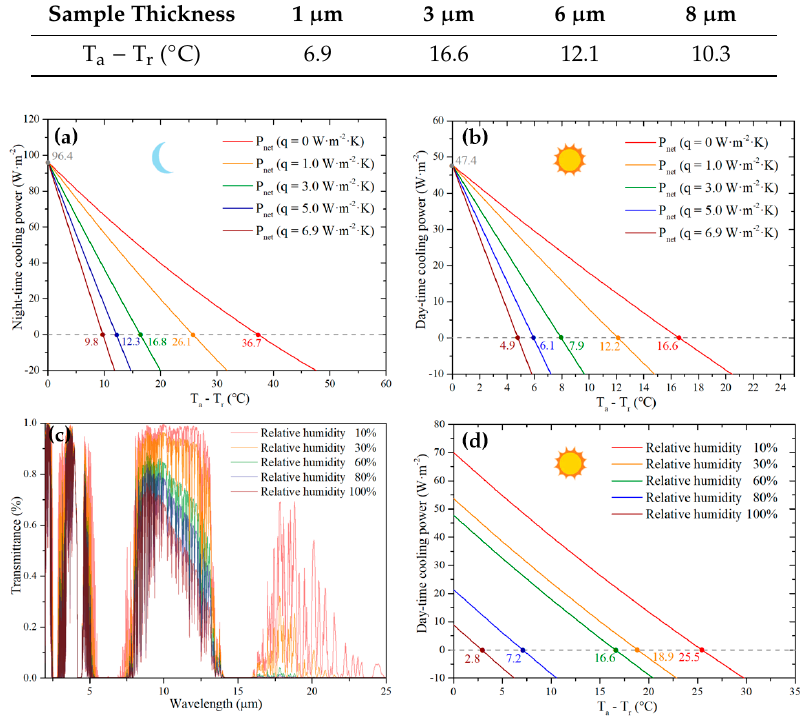
Table 2. Theoretical daytime cooling performance of the samples with di ff erent film thicknesses.